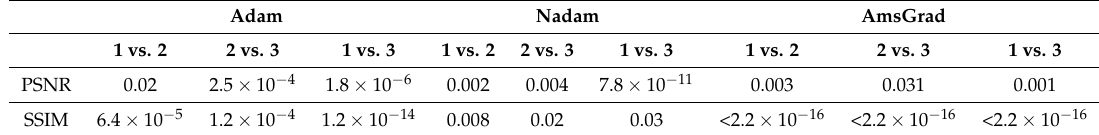
Table 6. Summary of Wilcoxon test between different number of anomalies for each optimizer. Adam Nadam AmsGrad 1 vs.